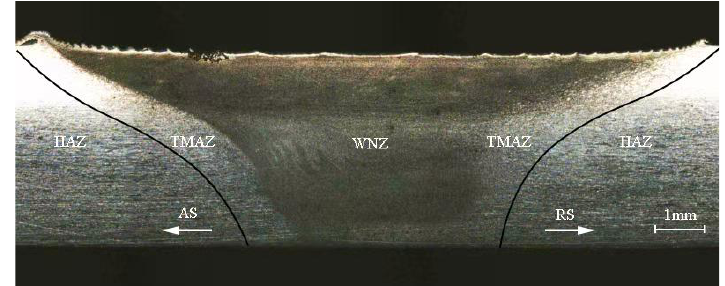
Figure 3. Cross-sectional morphology of the friction stir welded (FSW) joint.